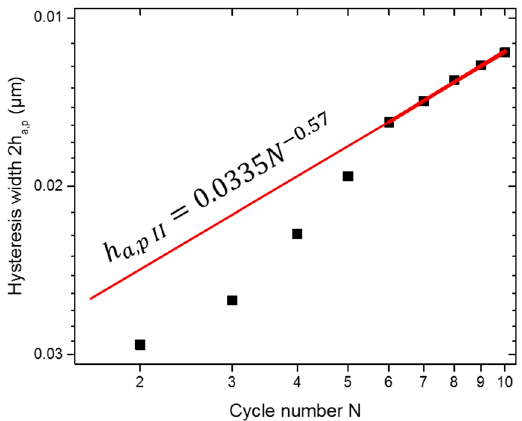
Figure 6. Plastic indentation depth amplitude h a,p vs indentation cycles N and the power-law describing the h a,pII with respect to N for N ≥ 6.